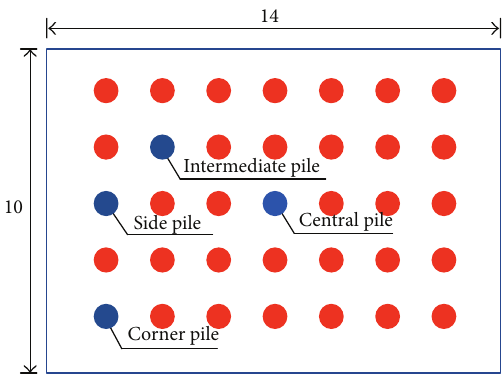
Figure 10: Distribution of CFG piles (unit: m).